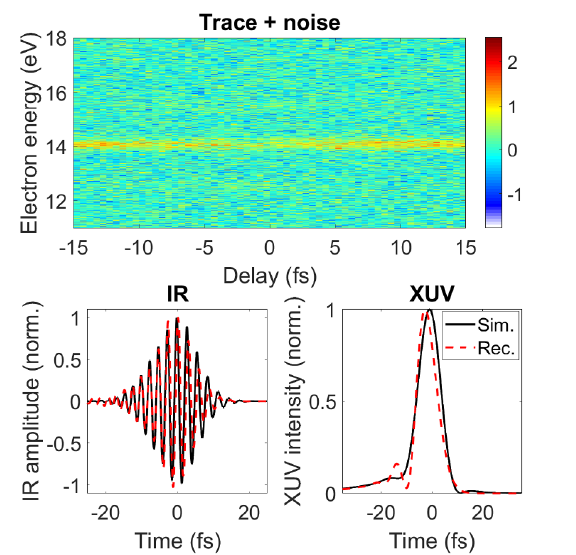
Figure 3. Results of the STRIPE reconstruction, with a large white noise applied to the SFA trace. The top panel shows the noisy simulated trace, whereas the bottom panels show a com- parison of the simulated and reconstructed pulse. Despite the signal-to-noise ratio is very low, STRIPE can recover the pulses with almost the same accuracy.